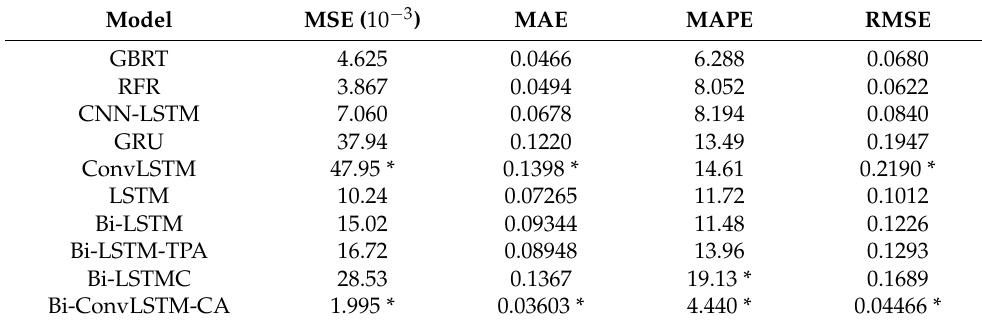
Table 2. Prediction performance indexes of each